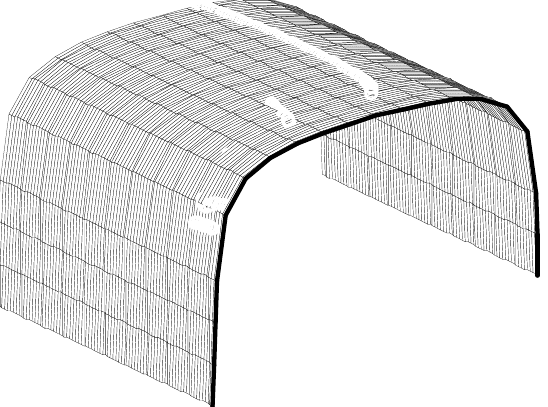
Figure 10. The positions of contact points on the surface of a rail (rail inclination 1:20).